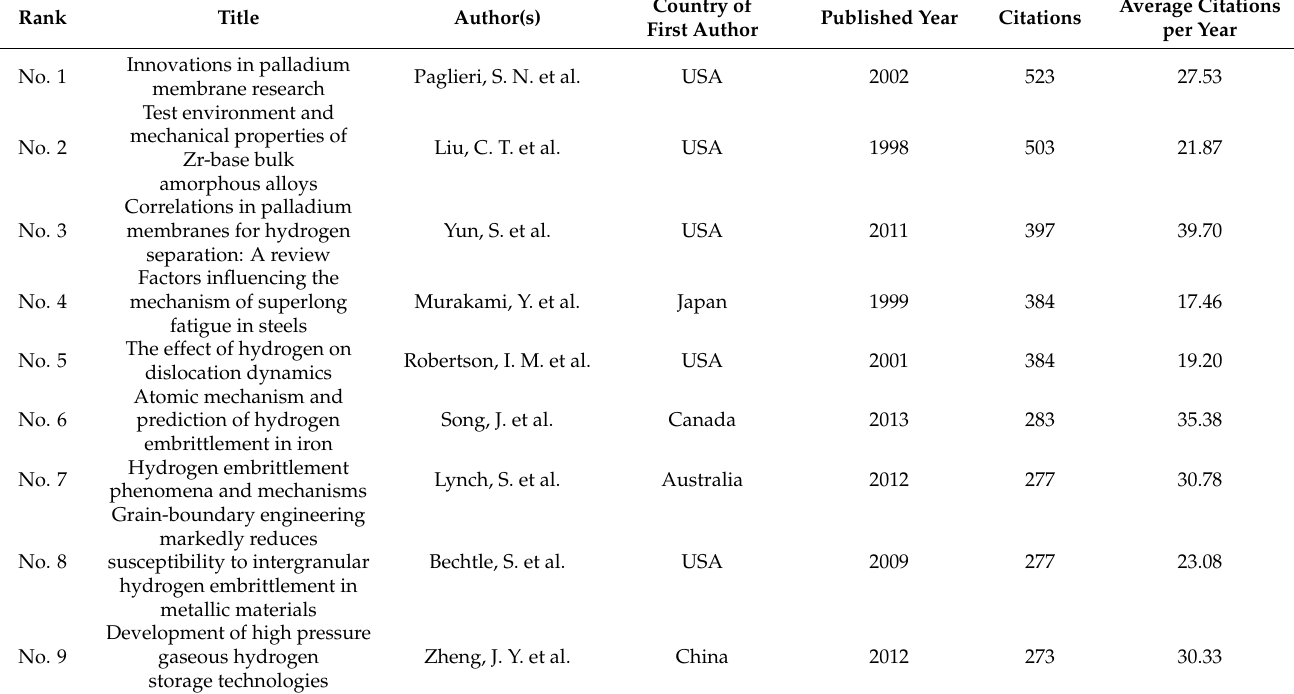
Table 6. Top nine most frequently cited publications on hydrogen